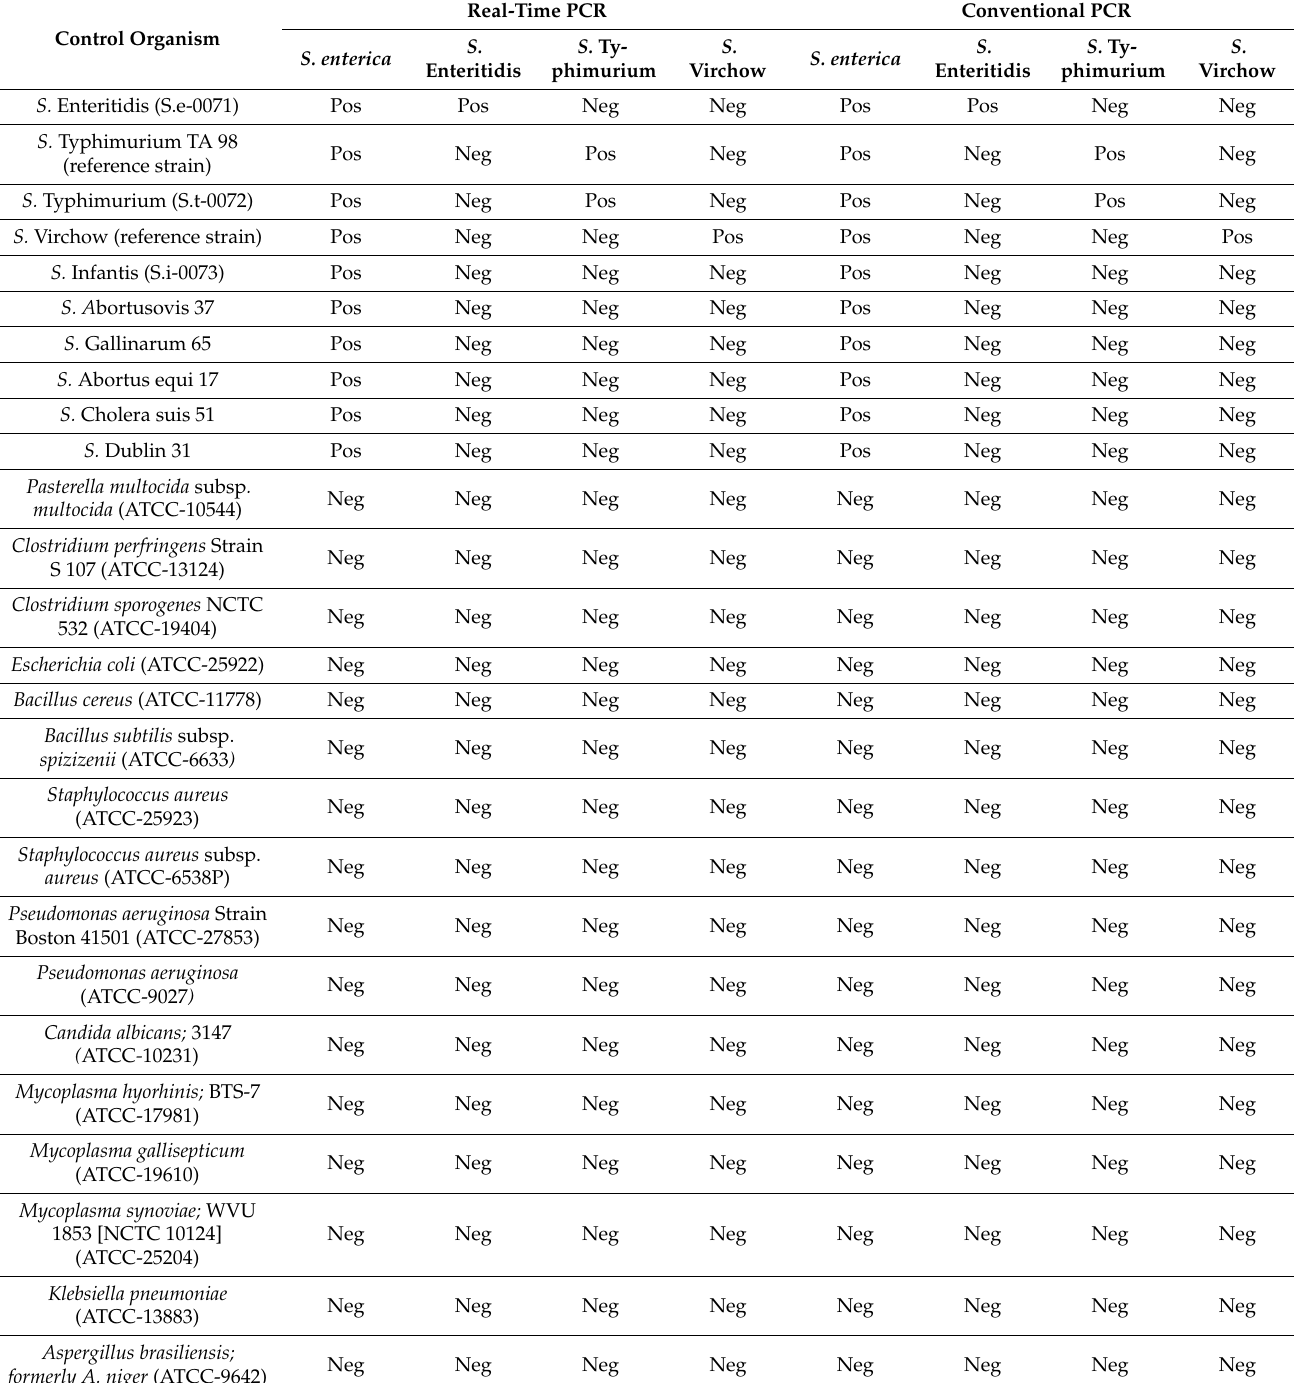
Table 3. Diagnostic specificity of conventional PCR and real-time